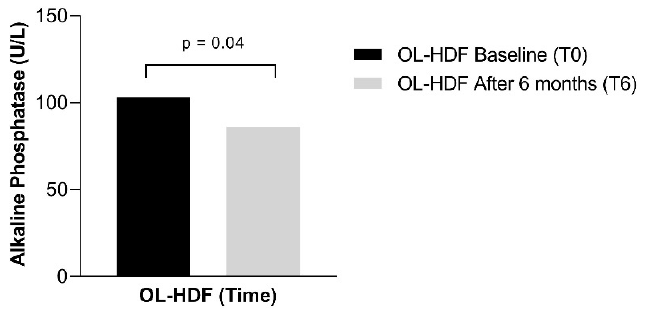
Figure 2. Correlation between Indoxyl sulfate (IS) and intact parathyroid hormone (iPTH), phosphate and 25 vitamin D.